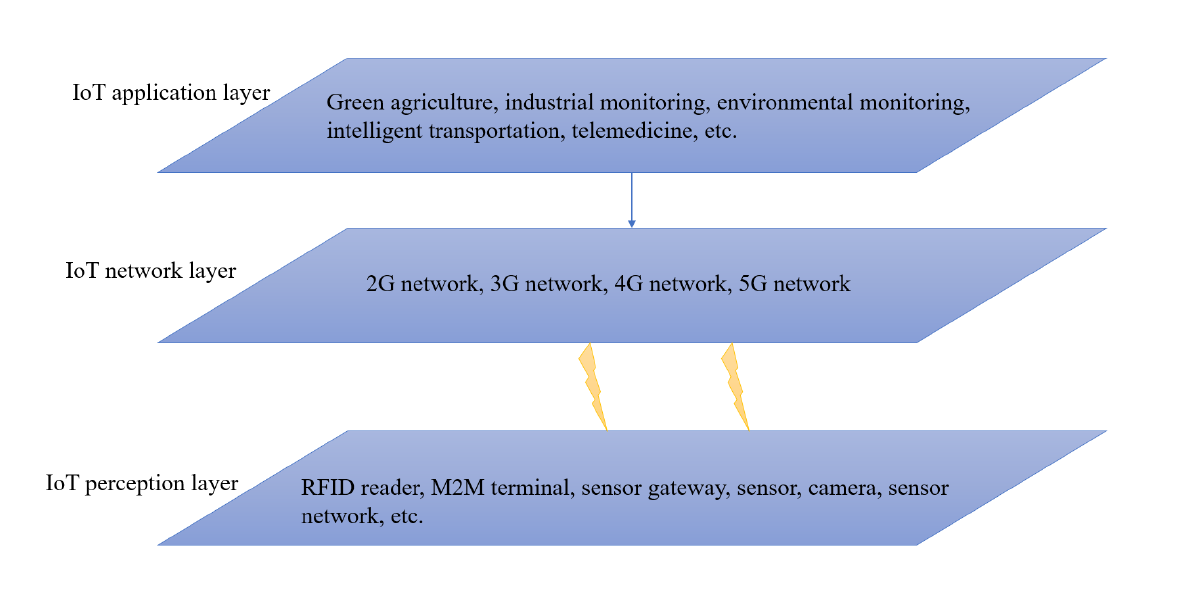
Figure 1. A three-tier conceptual model of the Internet of Things